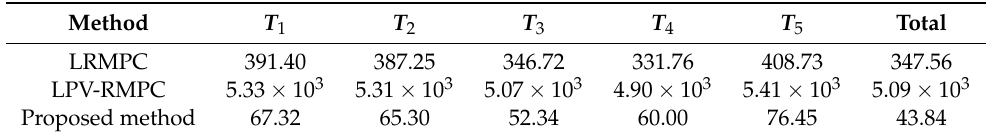
Table 3. The steady-state and initial